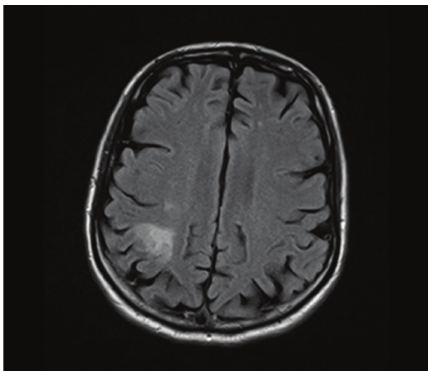
Figure 1: Subacute right posterior parietal infarct.